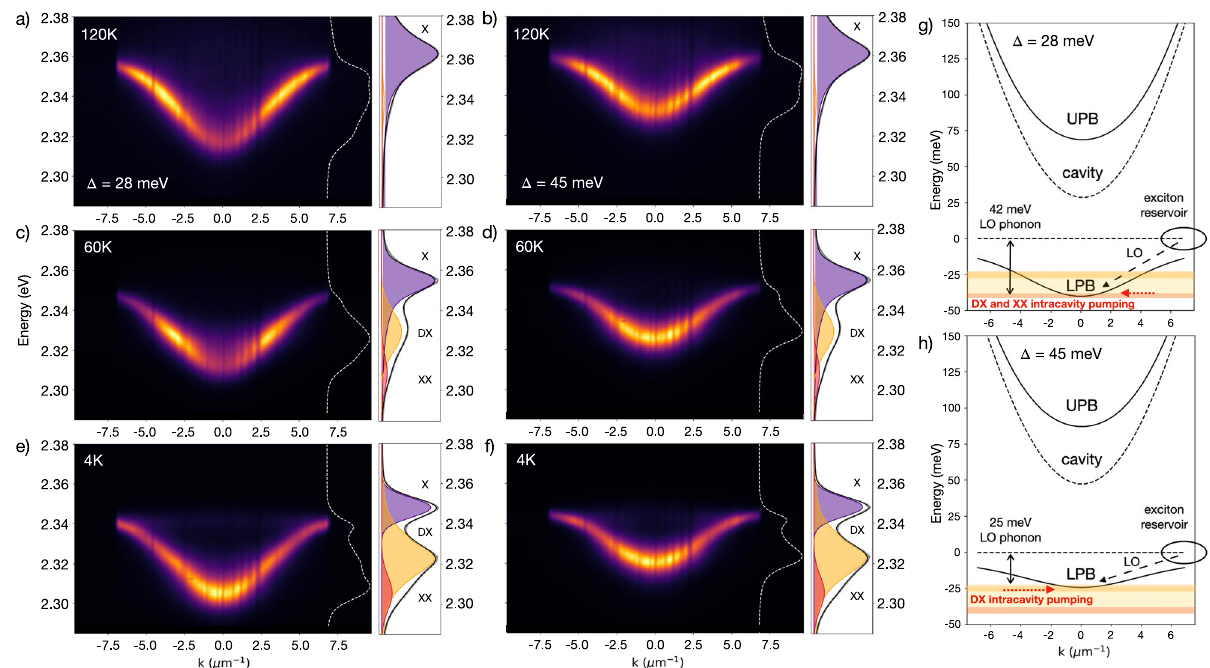
Fig. 5 | Exciton-polariton relaxationschemes towards bottleneck suppression. a – f Lower polariton branch (LPB) photoluminescence (PL) as a function of tem- perature for two detunings established at room temperature ( Δ = +28meV and +45meV) with (right panel) bare 2D perovskite fi lm PL at the corresponding tem- perature(brightexciton=X;darkexciton=DX;biexciton=XX). a , c , e Forthemore photonic detuning ( Δ = +28meV), the re-centering of the PL distribution to k || = 0